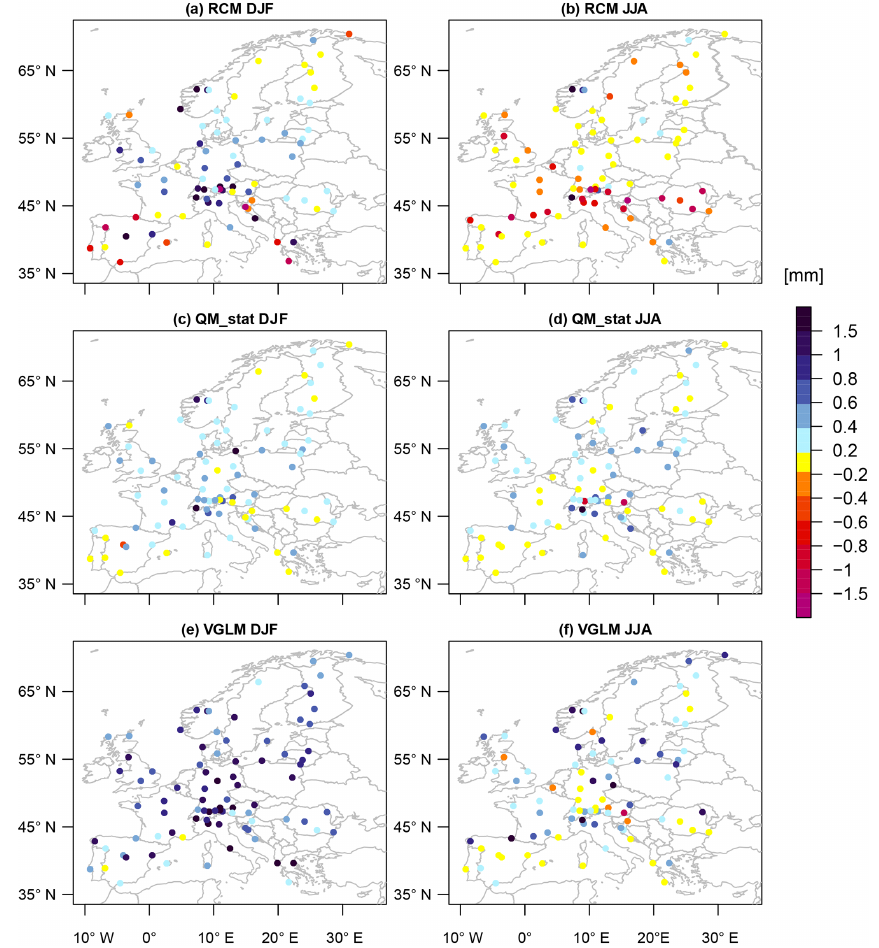
Figure 3. Mean bias. (a, b) Uncorrected RCM, (c, d) QM point -corrected RCM to the point scale, and (e, f) combined model selected predictor (RCM or QM grid -corrected RCM) and VGLM. Reference is station